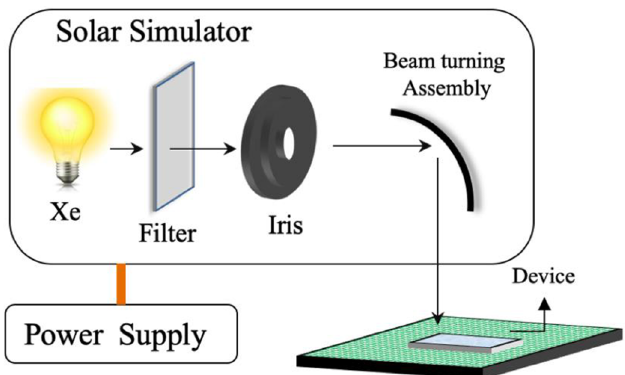
Fig. 3. Experimental setup using the solar simulator (SF300A) with